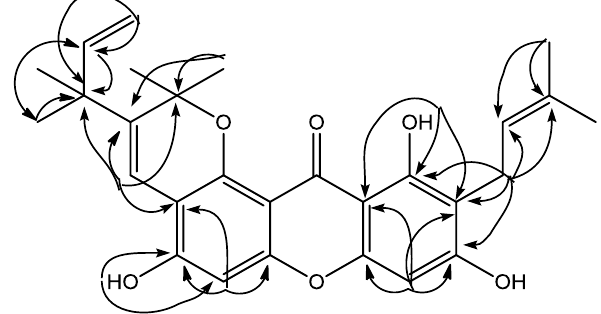
Figure 2. Selected HMBC correlations for 1 .